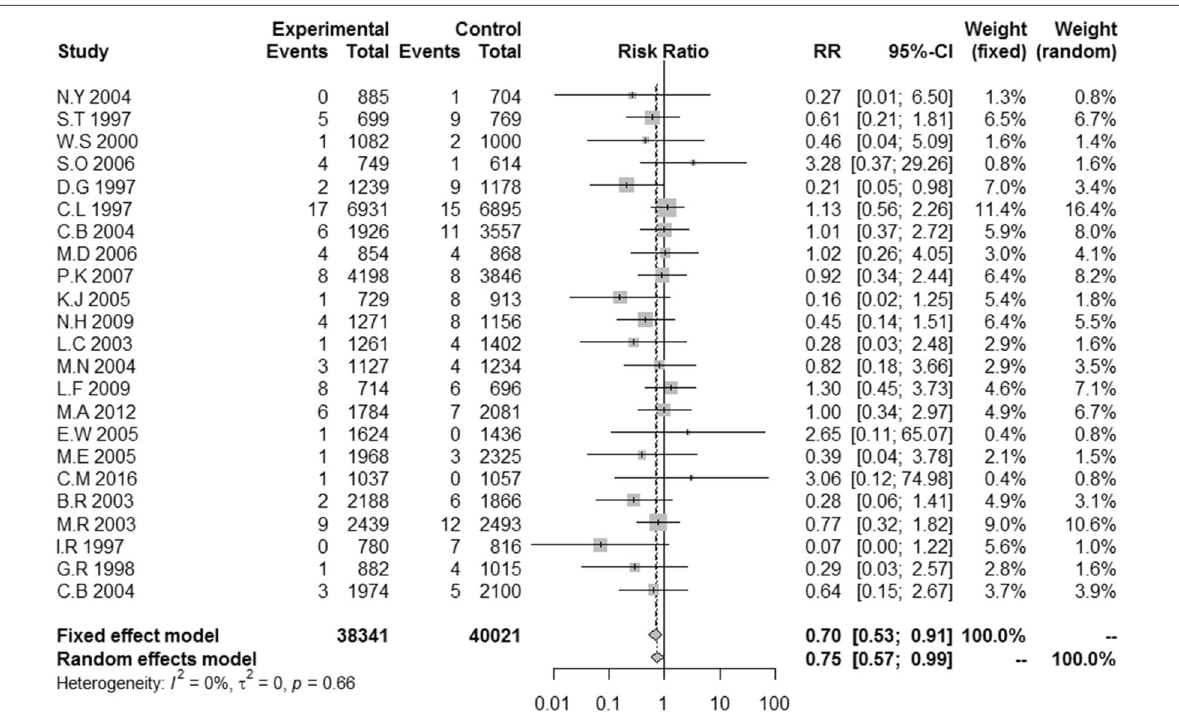
Fig. 2 Relative risks for the rate of CRBSIs per 1000 catheter-days in the classic meta-analysis between antimicrobial-impregnated and standard non-impregnated